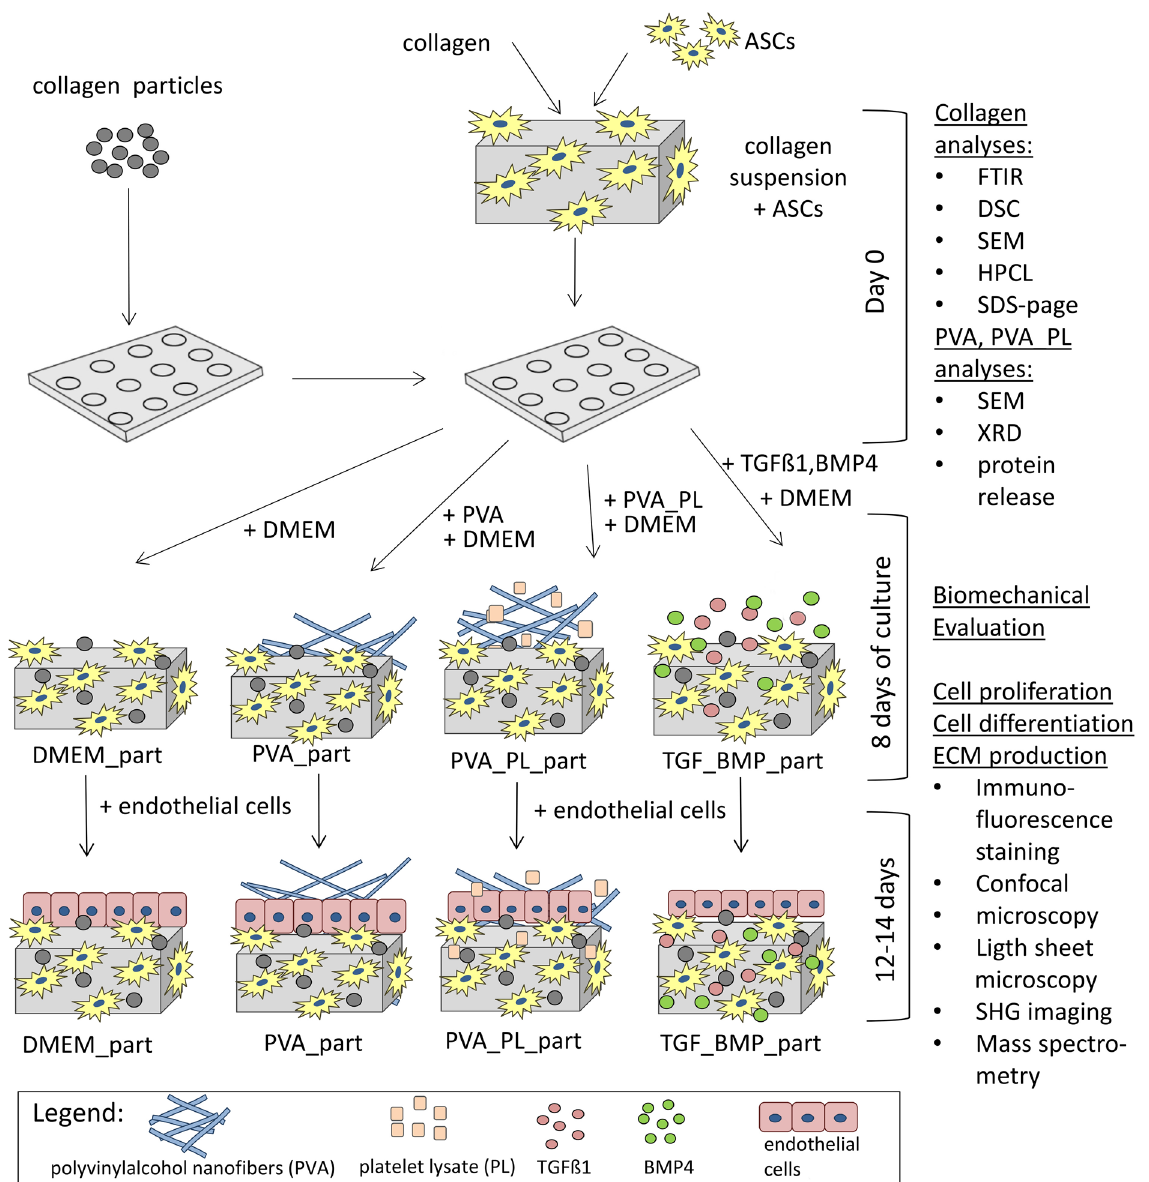
Figure 12. Scheme of the experiments.